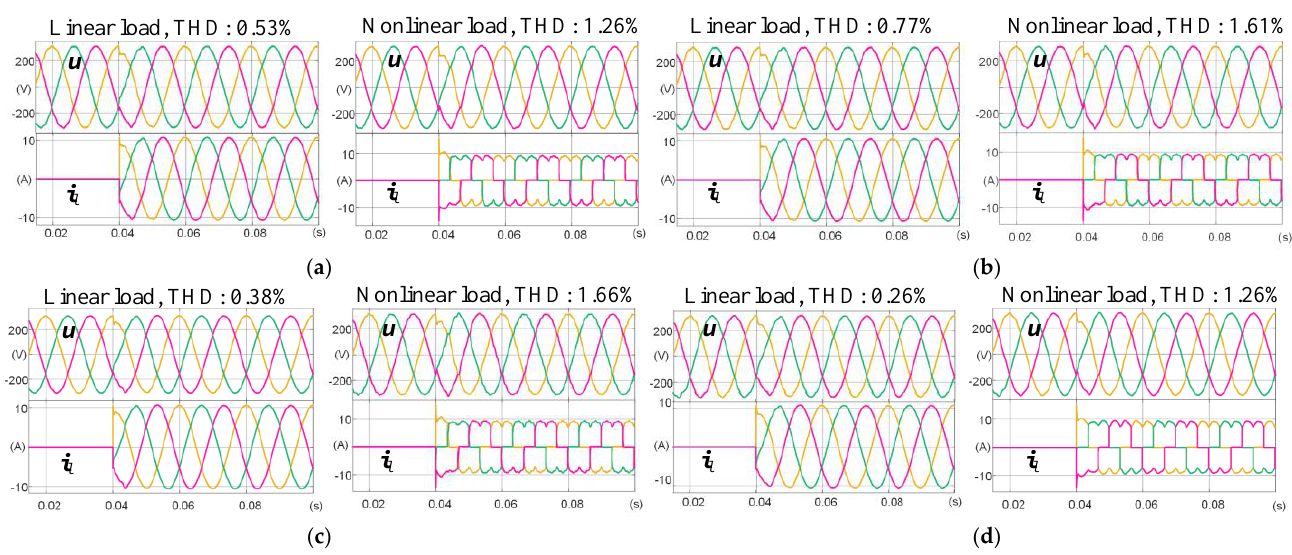
Figure 6. Simulation results of the proposed optimal control law with different LC filter parameters: